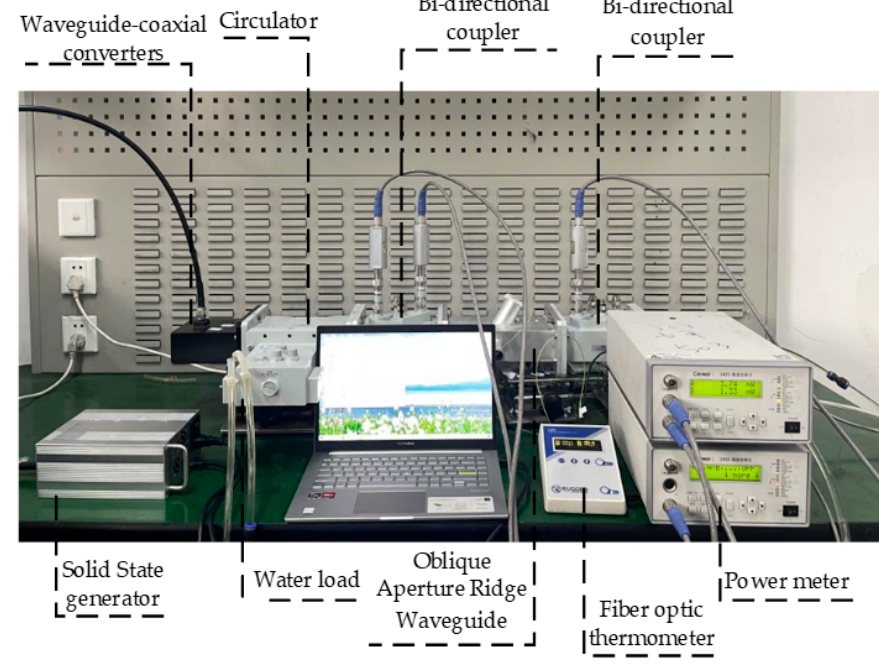
Figure 7. Photo view of the permi tt ivity measurement system.